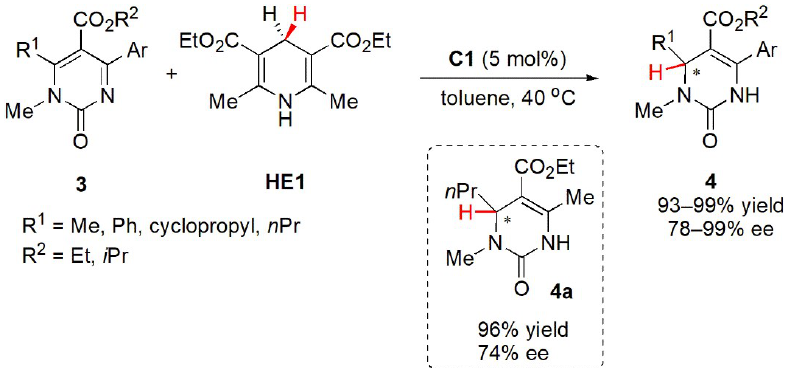
Figure 3. Enantioselective 1,4-reduction of pyrimidin-2-ones to 3,4-dihydropyrimidin-2(1 H )-ones [39]. In a more recent development, chiral non-racemic phosphonyl ester-substituted DHPMs were synthesized by a redox deracemization reaction [40]. This procedure involved an oxidation reaction to destroy the stereocenter in racemic phosphonyl- substituted dihydropyrimidines rac - 5 , pre-prepared from the known corresponding pyrimidin-2-ols by reaction with a phosphite and zirconium tetrachloride (Figure 4). This was followed by ETH to regenerate the chiral carbon center bearing the vicinal phosphonic ester group, which gave rise to a series of optically active phosphonate substituted DHPMs ( R )- 5 with up to 96% ee. The oxidation and transfer hydrogenation reactions could be performed in one pot with DDQ as an oxidant, with the chiral catalyst and reducing agent being added once the oxidation was complete, as evidenced by TLC. It was assumed that the reaction proceeded via the oxidation of the racemic starting mixture to an aromatic intermediate I, followed by a CPA-facilitated reversible isomerization to yield tautomer II. 1,2-Hydrogenation of the C=N bond yielded the final product. This hypothesis was supported by an additional experiment with a hydroxyl- protected substrate, for which no reaction could be observed under the standard conditions. A large range of diversely substituted substrates could be used successfully. However, if R 1 = Me, the ee dropped to 5% with a 94% yield. The nature of the phosphonyl ester substituents was also important, and the best results were obtained when they were diisopropyl. When these were phenyl groups, no ETH was observed. The reaction could also be performed on a gram-scale, e.g., with 5a ( 5 : R 1 = Ph, R 2 = H), to afford the corresponding product in 92% yield and 96% ee. Figure 4. Redox deracemization of phosphonate-substituted dihydropyrimidines [40]. b.